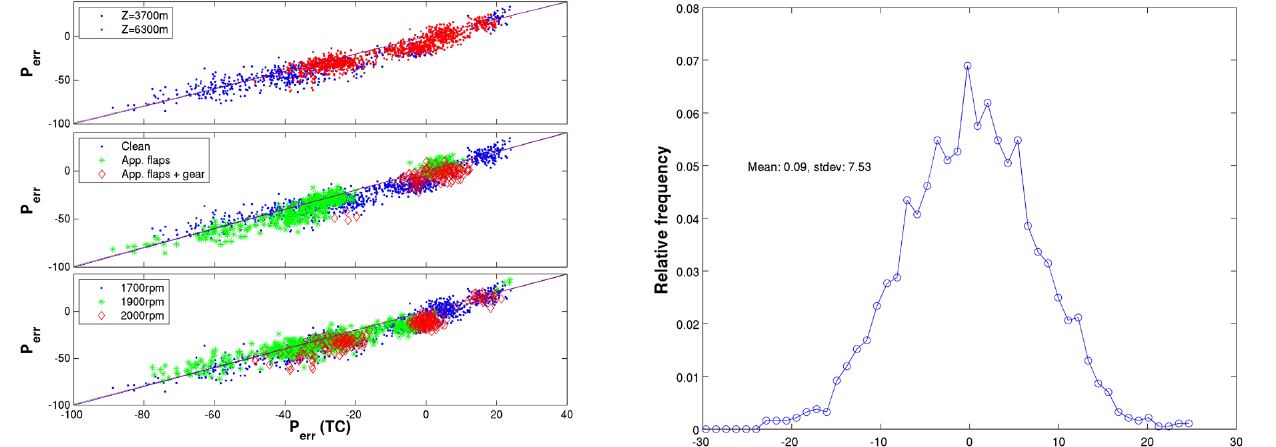
Fig. 4. Pressure error [ Pa ] predicted from differential pressure algo- rithm vs. error measured with TC for various flight configurations, altitudes and propellor speeds, as indicated in legends (10Hz data). 1 : 1 lines are shown.